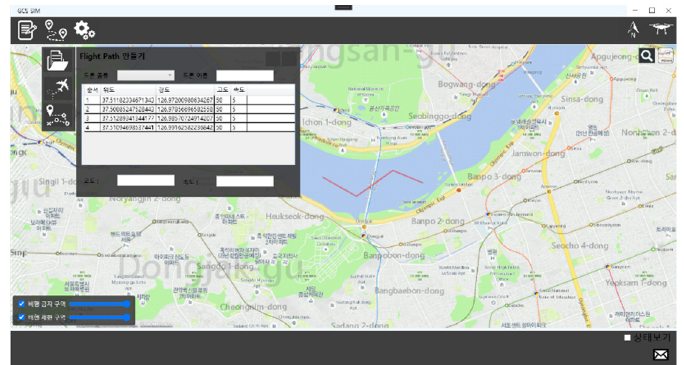
Figure 3. GCS UI—flight plan generation.